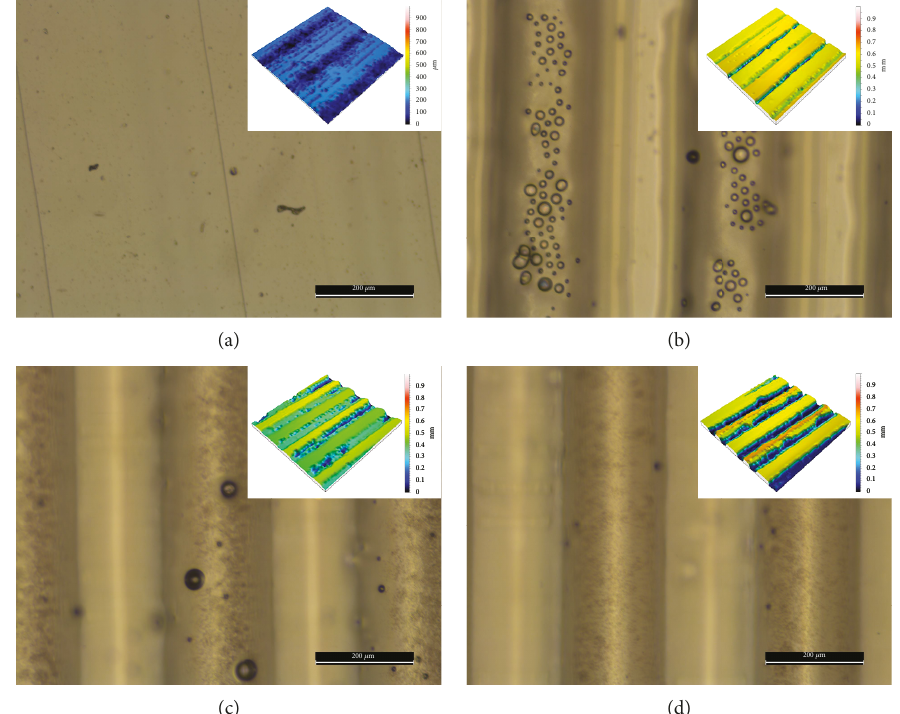
Figure 3: Optical micrographs of 4 laser-processed PET samples with increasing laser power. (a) 5%; (b) 10%; (c) 15%; (d) 20%. All samples have been processed at a scanning speed of 200mm/s and at 400 μ m spacing. The insets are CCI surface maps that have been set to the same z scale, and horizontally the scale bar is equal to 200 μ